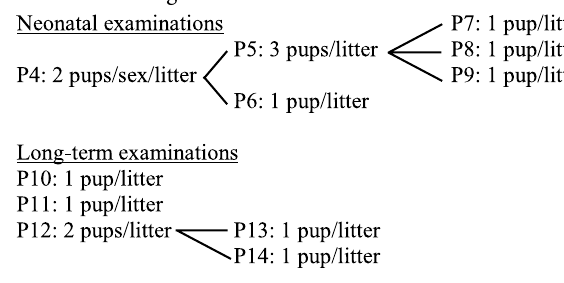
Frontiers in Toxicology |